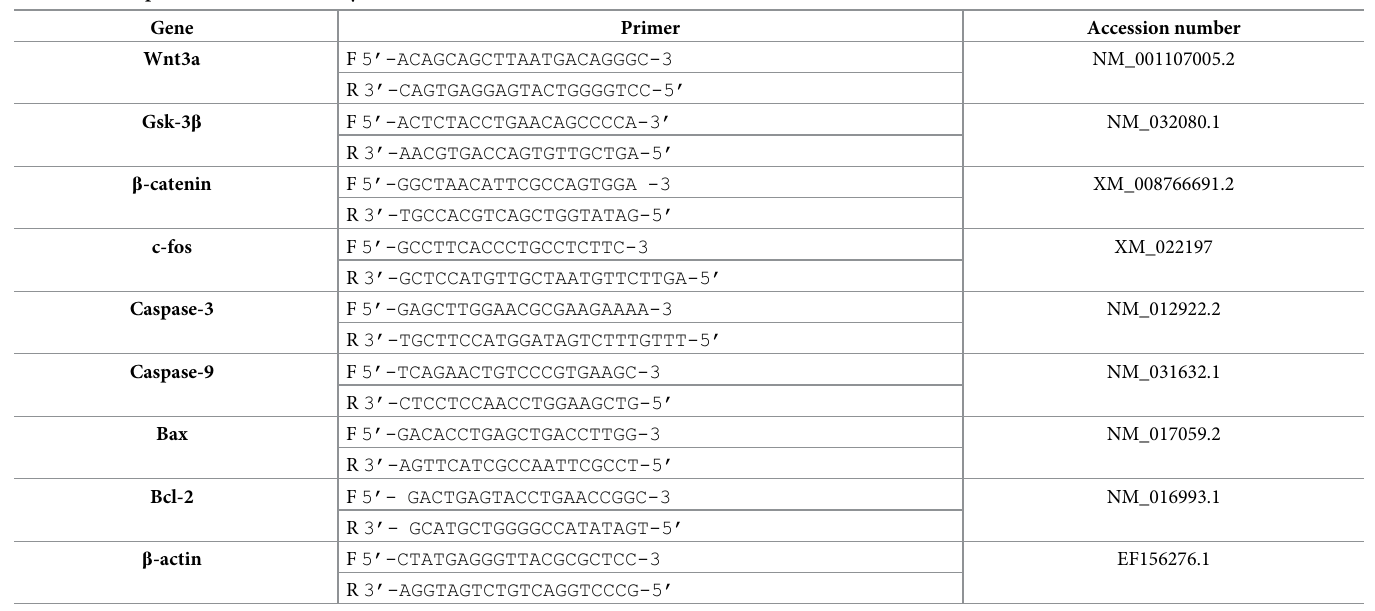
Table 1. List of primers used in this study.